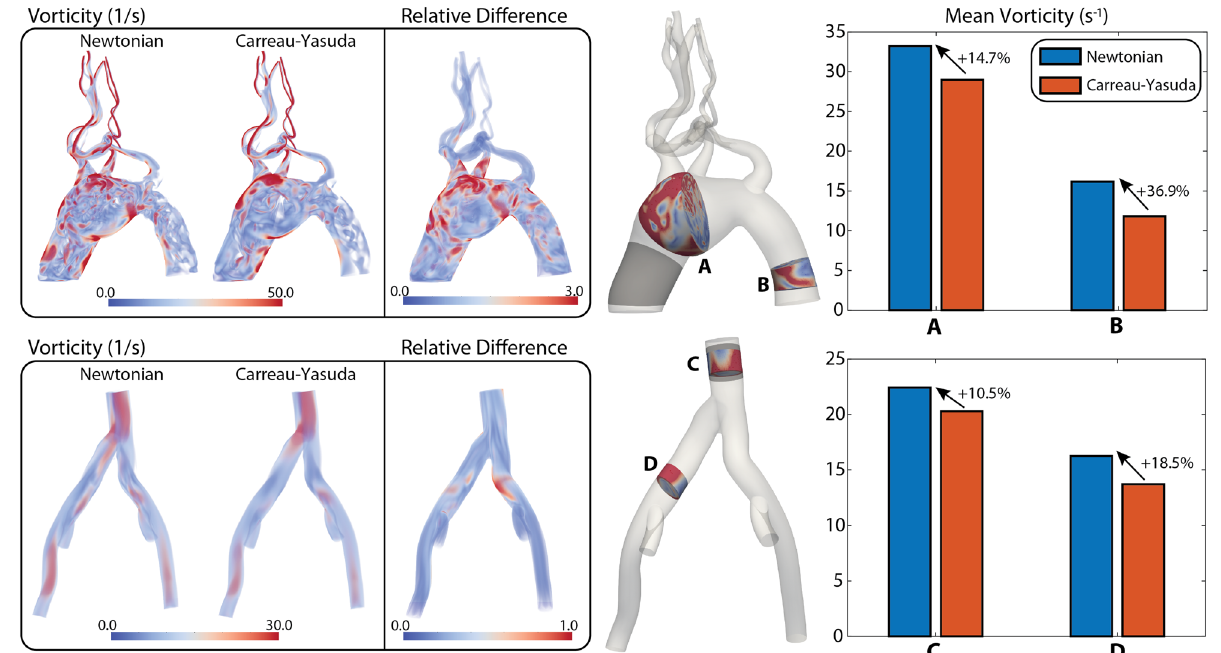
Figure 3. Arterial and venous vorticity in diastole. (Left) Volume rendering plots of vorticity magnitude for the Newtonian and Carreau-Yasuda models, and relative difference between the two. (Right) Bar plots of mean values for four representative locations ( A – D ).